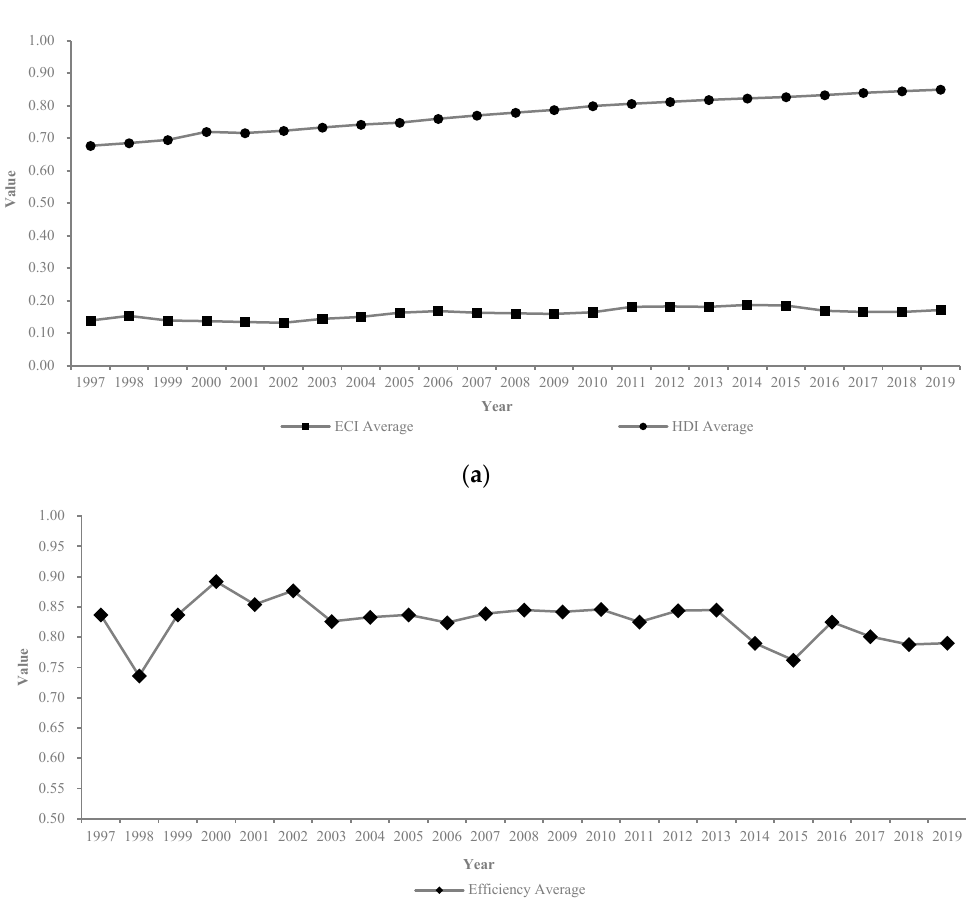
Figure 4. ( a ) The average values of the ECI and HDI among 30 provinces from 1997 to 2019 in China. ( b ) The average value of the EWP efficiency among 30 provinces from 1997 to 2019 in China.